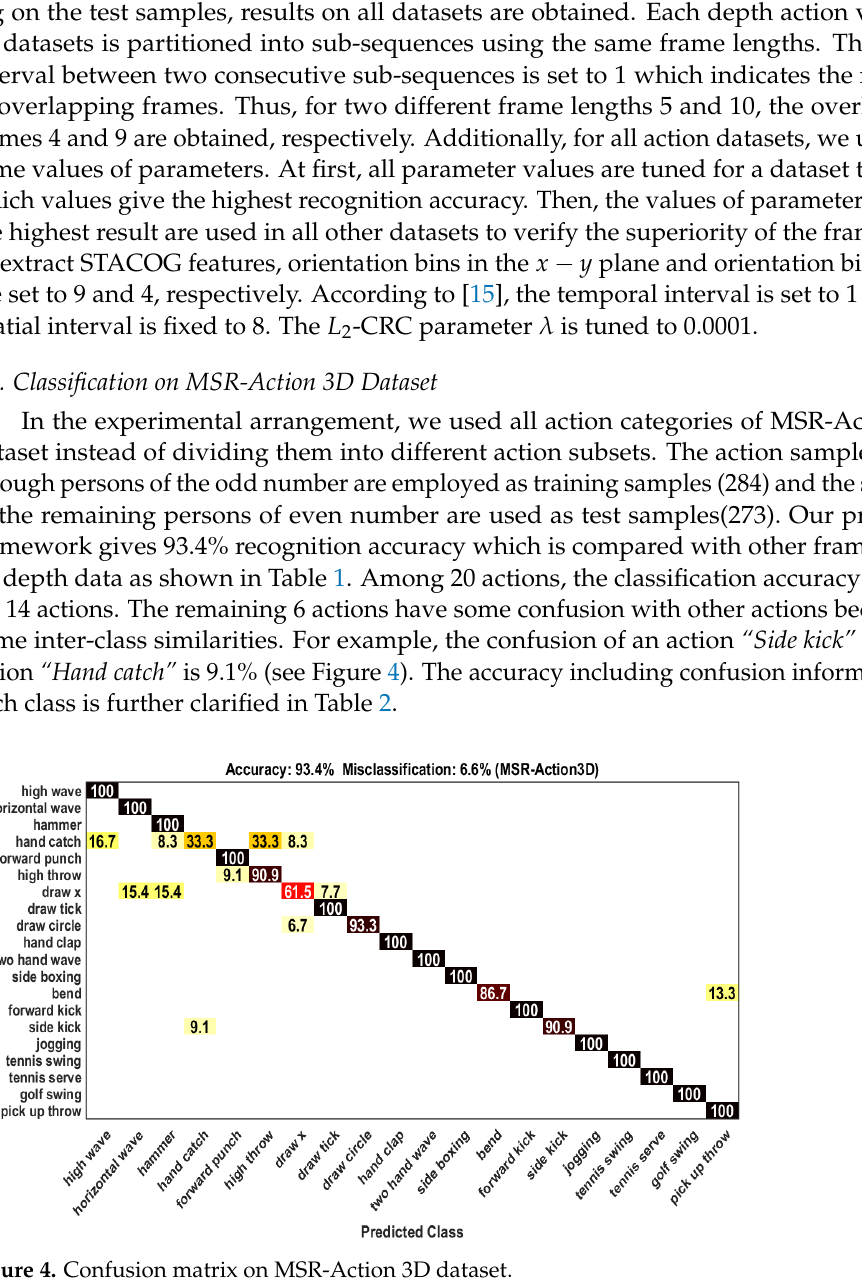
Figure 4. Confusion matrix on MSR-Action 3D